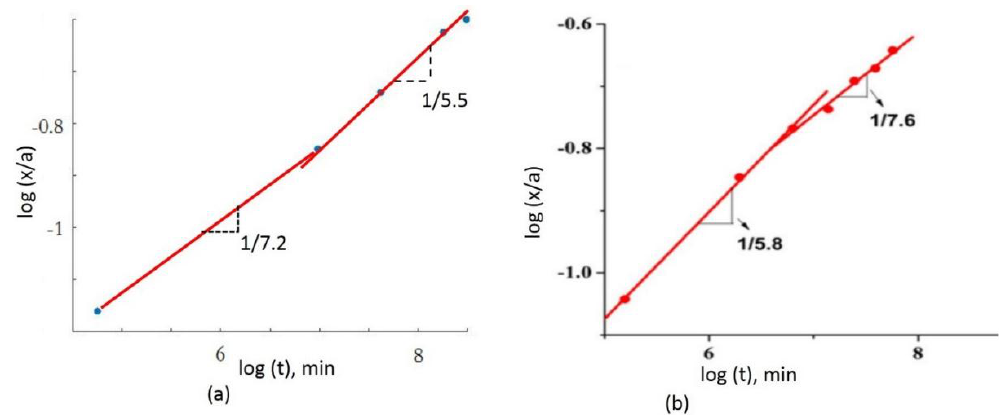
Figure 4. Sintering neck extraction by watershed method: The cross section image ( a ), the result of watershed algorithm ( b ), and the extracted sintering necks ( c ).